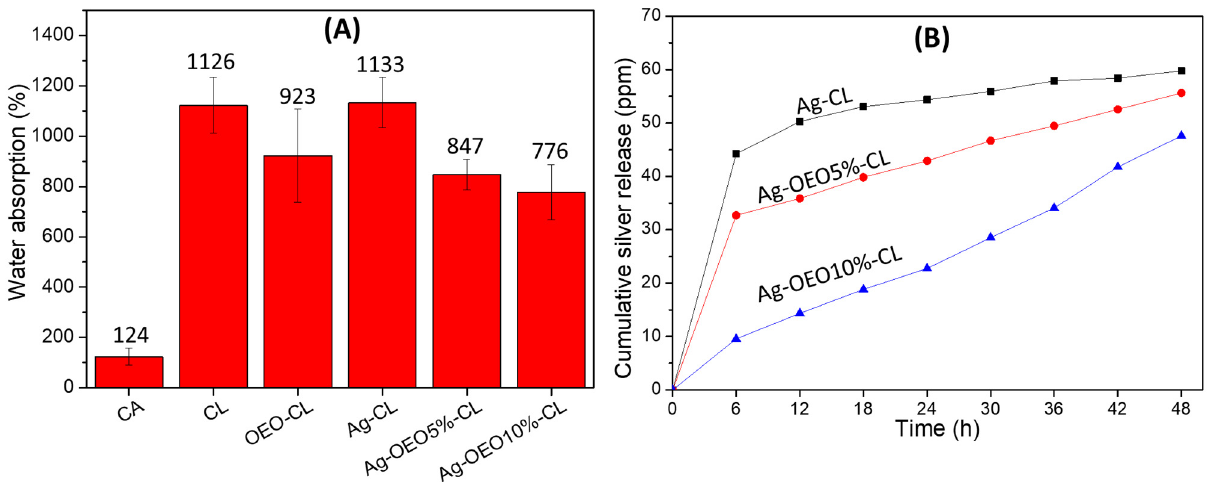
Figure 6. ( A ) Water absorption of CA, CL, OEO-CL, Ag-CL, Ag-OEO5%-CL, and Ag-OEO10%-CL. ( B ) Silver release behavior of Ag-CL, Ag-OEO5%-CL, and Ag-OEO10%-CL.